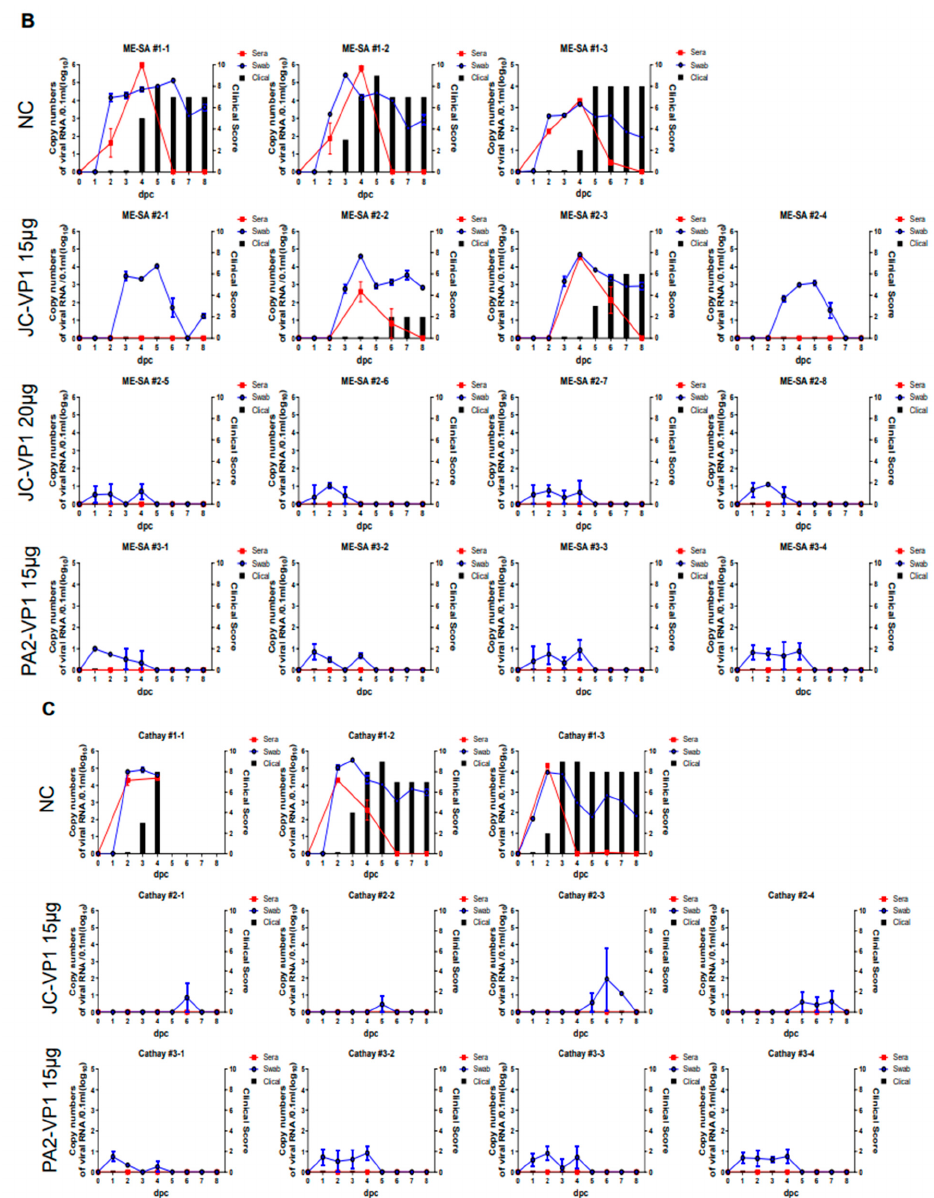
Figure 4. Protection in immunized pigs challenged with the viruses of the three different topotypes after vaccination with JC-VP1 or PA2-VP1. The negative control groups (#1-1, #1-2, #1-3) and vaccinated group with JC-VP1 or PA2-VP1 (#2-1, #2-2, #2-3, #2-4, #3-1, #3-2, #3-3, #3-4 were tested using a 15 µ g inactivated antigen vaccine and #2-5, #2- 6, #2-7, #2-8, #3-5, #3-6, #3-7, #3-8 were tested using a 20 µ g inactivated antigen vaccine) were challenged with SEA ( A ), ME-SA ( B ), and Cathay ( C ). Clinical scores (black bar), viremia (red, serum; blue, oral swab) were evaluated up to 8 days post-challenge. The JC-VP1-vaccinated groups were challenged with the viruses of the three different topotypes. Complete protection against SEA and Cathay was confirmed when the pigs were vaccinated with 15 µ g of inactivated antigen vaccine of JC-VP1, but only 50% protection against ME-SA was confirmed. Complete protection against ME-SA was confirmed when tested using 20 µ g of inactivated antigen vaccine of JC-VP1. The PA2-VP1-vaccinated groups were challenged with the viruses of the three different topotypes. Complete protection against the three topotype viruses was confirmed when the pigs were vaccinated with 15 µ g or 20 µ g of inactivated antigen vaccine of